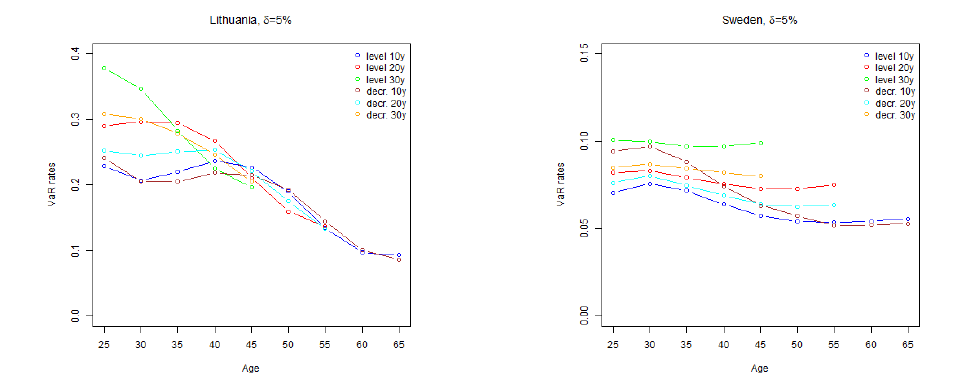
Figure 2. Calculated run-off VaR rates at policy inception by country for different ages at policy inception, three different terms to maturity (10 years, 20 years and 30 years) and two benefit formulas (level sum assured and sum assured decreasing with